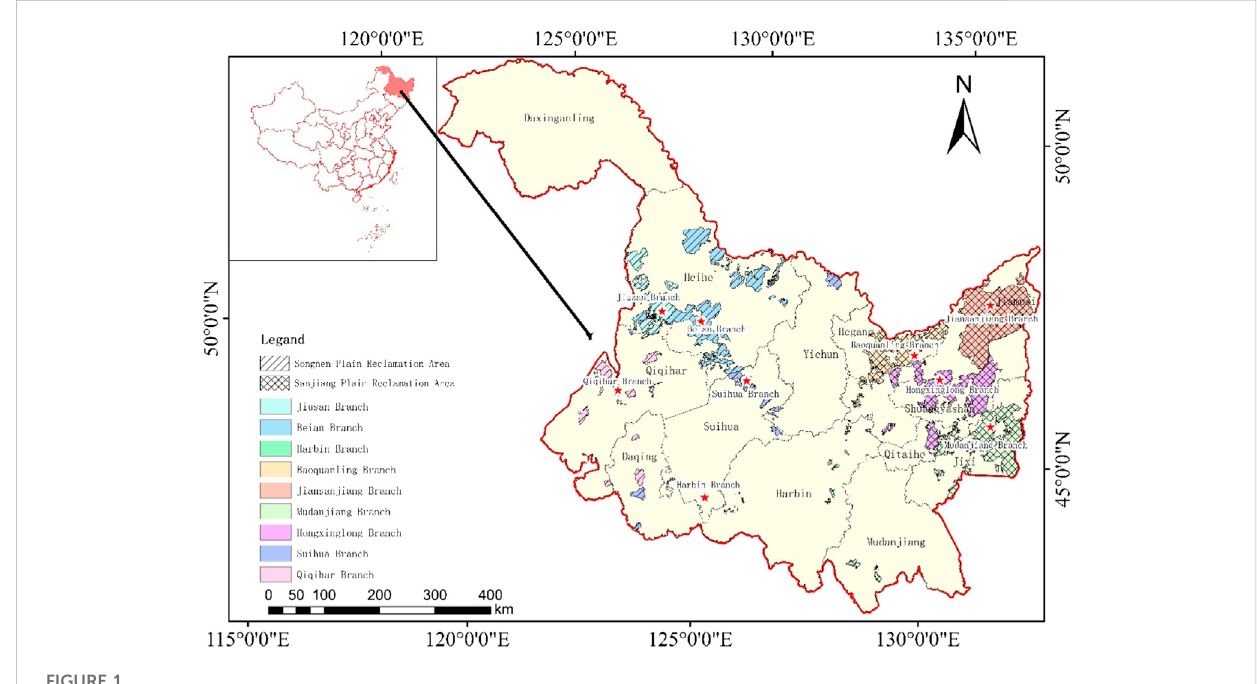
FIGURE 1 Heilongjiang Reclamation Area spatial distribution